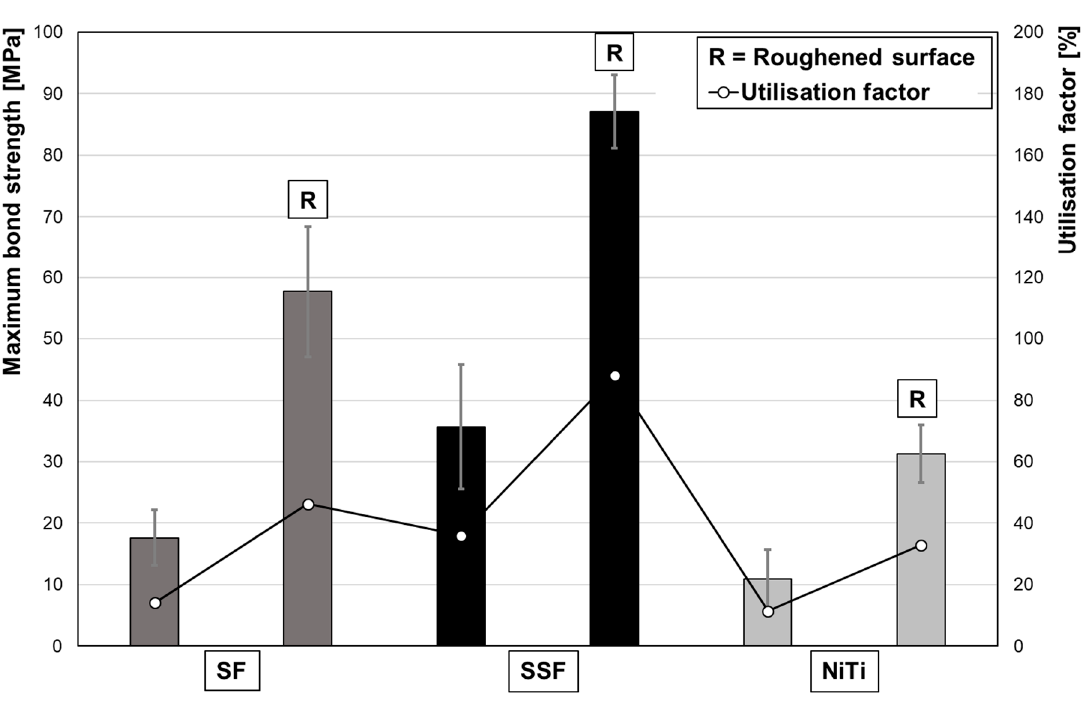
Figure 8. Influence of surface topography on the bond between fibre and concrete matrix. Maximum bond stress and utilisation factors of the untreated and roughened surfaces of the different fibre types.